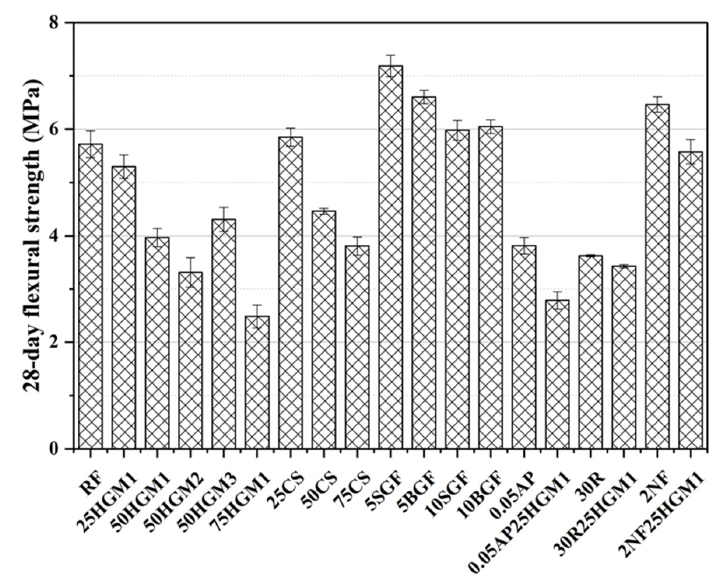
Figure 7. 28-day flexural strength of specimens.